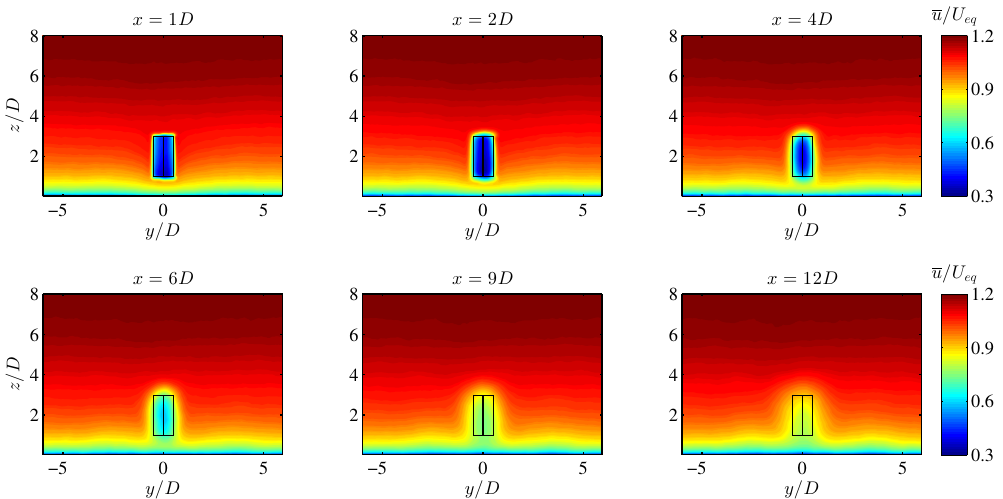
Figure 8. Contour plots of the normalized mean streamwise velocity ( u / U eq ) in six different y - z planes at different distances downstream of the center of the